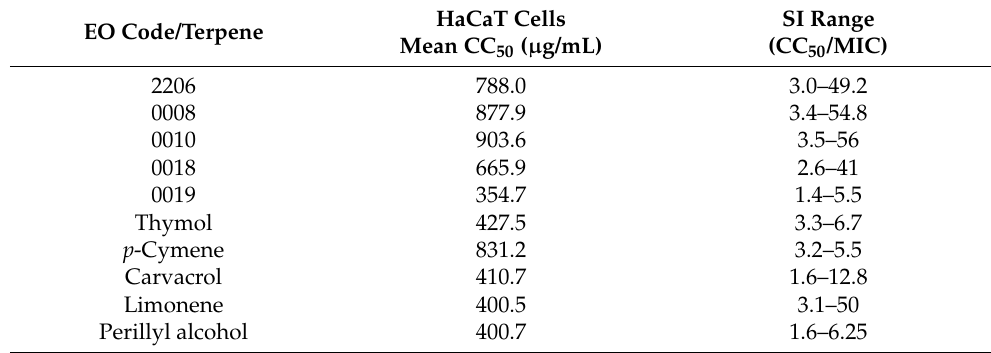
Table 5. The 50% cytotoxic concentration (CC 50 ) and SI values of the most active EOs and commer- cial